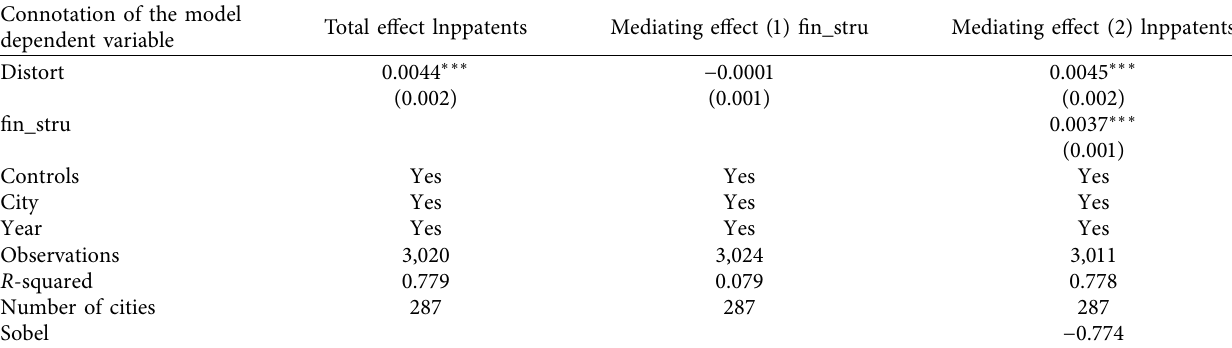
Table 8: Results of financial structure mediating effect test.